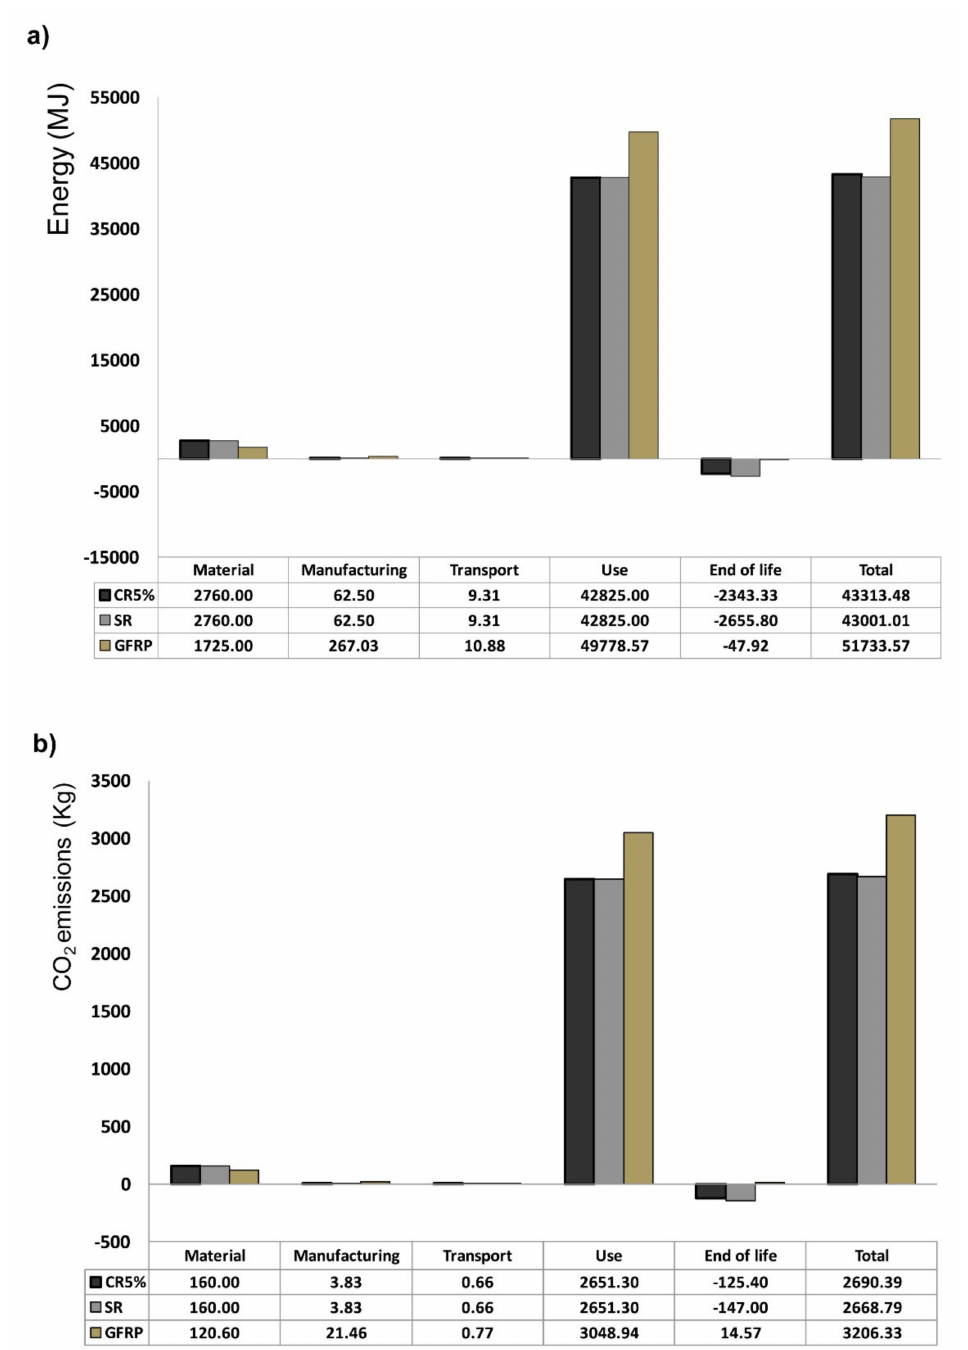
Figure 12. Comparative life cycle inventory results: ( a ) primary energy, ( b ) CO 2 emissions. Reprinted from [66], © 2020 with permission from